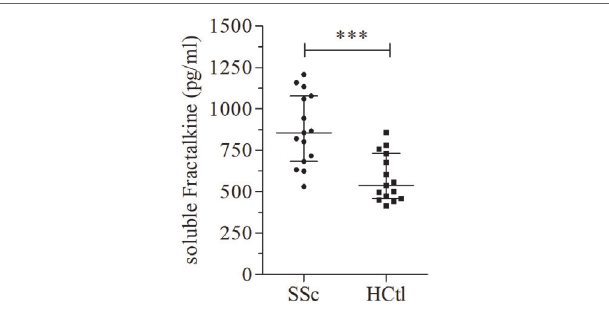
FigUre 2 | Soluble fractalkine levels in systemic sclerosis (SSc) patients. Soluble fractalkine levels were quantified with ELISA, in the serum of SSc patients ( n = 15) and healthy controls (HCtl) ( n = 15). Results were expressed as median ± interquartile range and statistical significance was established using the non-parametric Mann–Whitney U test. *** p < 0.001.